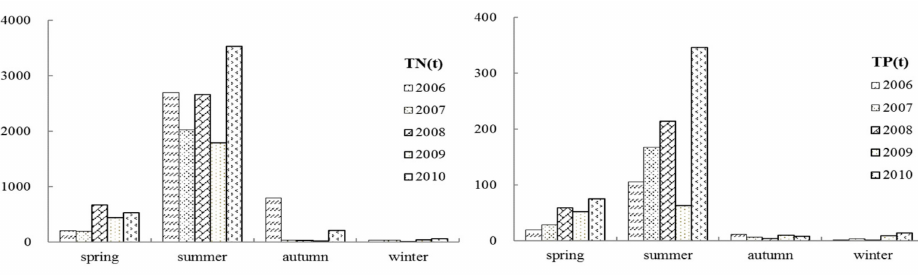
Figure 6. Average seasonal TN and TP loads from 2006 to